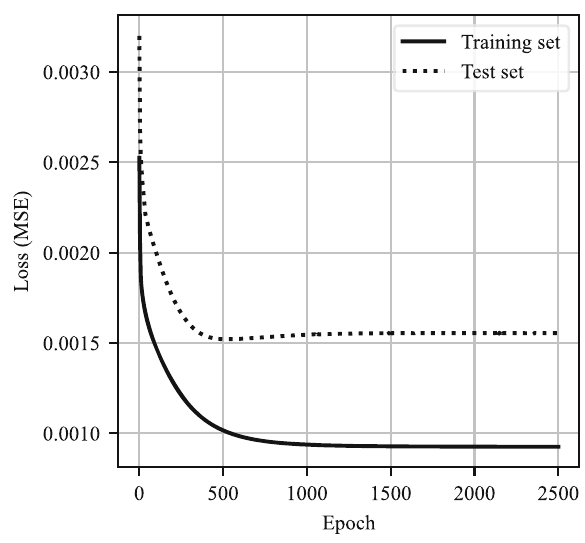
Fig. 5 Training and test set losses versus epoch during model training Table1 Average RMSEs in training set ( N = 252) for each channel with 95% CI and p -value FlyNet Classical p -value u [ft s − 1 ] 2.222 [0.327, 6.392] 3.623 [0.753, 22.473]